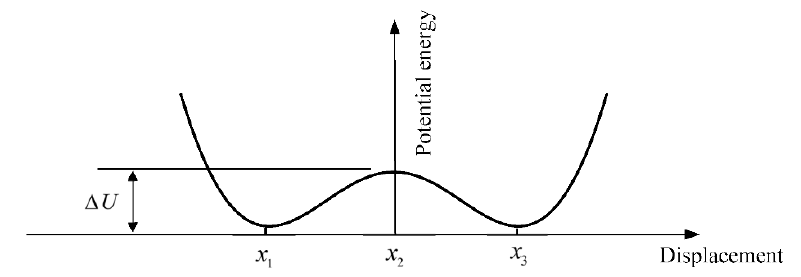
Figure 6. The distribution of potential energy with displacement of mass block.